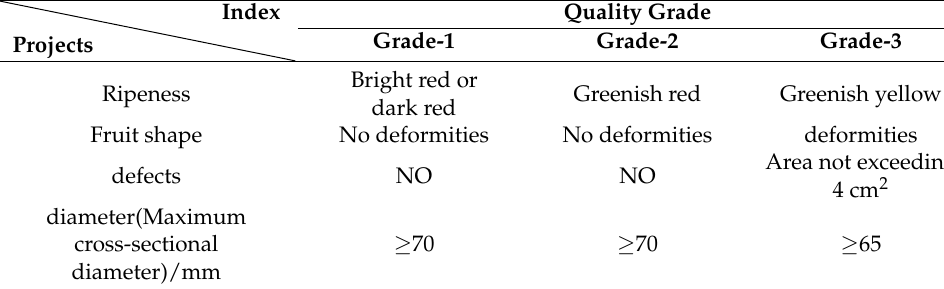
Table 1. Red Fuji GB/T 10651 ‐ 2008 national standard.